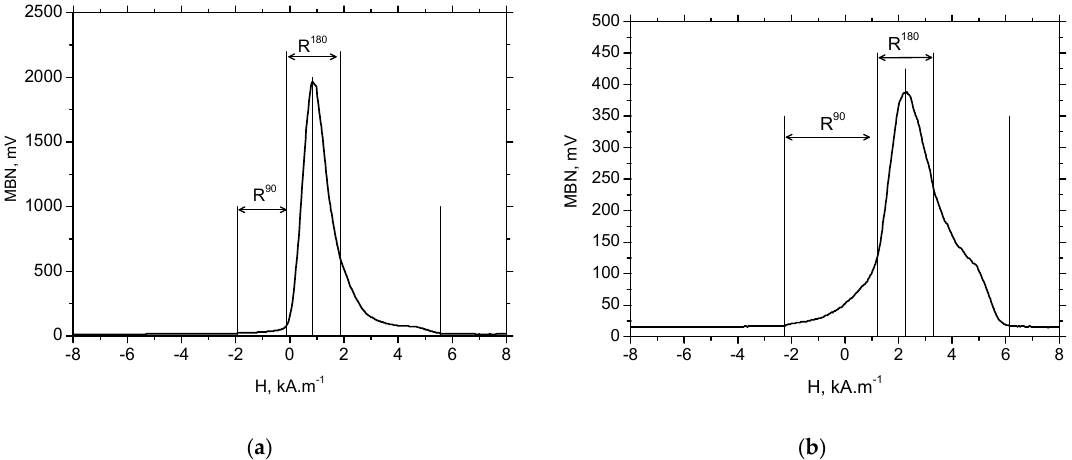
Figure 16. MBN envelopes for VB = 0.05 mm: ( a ) tangential direction, and ( b ) the axial direction.